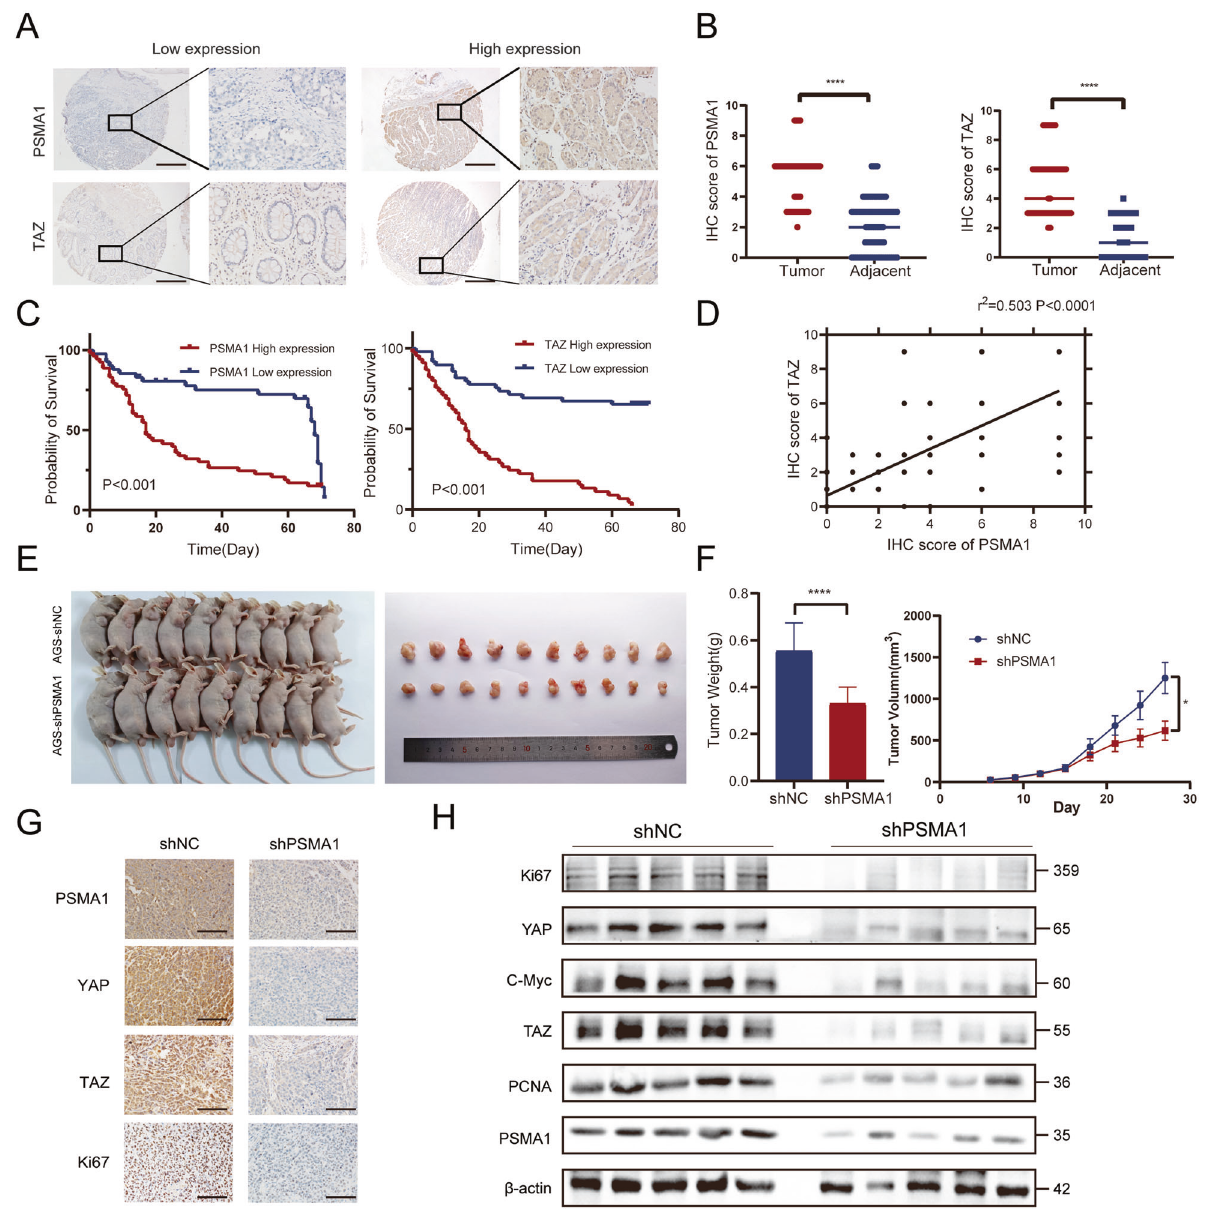
Fig. 7 PSMA1 upregulates TAZ to promote GC cell proliferation in vivo. A Representative image of IHC staining of tumor microarrays from GC patients. Bar length: 200 μ m. B IHC scores of PSMA1 and TAZ level between gastric cancer tissue and adjacent normal tissue. C The Kaplan – Meier plot of overall survival by the expression of PSMA1 and TAZ in tumor microarrays related information. D Pearson ’ s correlation was used to determine the relationship between PSMA1 and TAZ protein expression in gastric cancer tissue specimens. E AGS cells with/ without shPSMA1 were injected in nude mice. Representative images of xenograft tumors from mice bearing AGS-shNC and AGS-shPSMA1 cells. F Tumor volume was measured every 3 days. Tumor weight was calculated for each mouse. G PSMA1, YAP, TAZ, and Ki67 expression in the tumor of nude mice were detected by IHC. Bar length: 100 μ m. H Western blotting was conducted to measure the level of proliferation- related intratumor protein